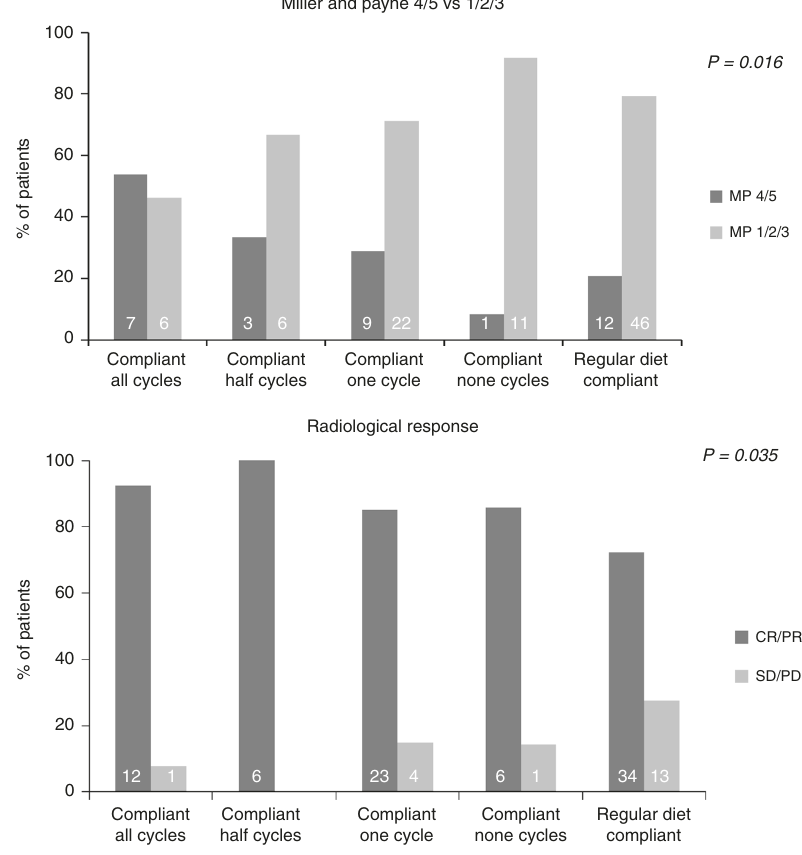
Fig. 4 Tumor response data per number of cycles completed. The pathological response was given for Miller and Payne pathological response score 4/5 (90 – 100% tumor cell loss) vs.1/2/3 (less than 90% tumor cell loss). The radiological response was scored according to RECIST 1.1 and given for complete response + partial response vs. stable disease + progression disease. P -value is given for Armitage ’ s trend test (2-sided). Abbreviations: FMD: fasting mimicking diet, MP: Miller and Payne, CR: complete response, PR: partial response, SD: stable disease, PD: progression disease. Source data are provided as a Source Data fi